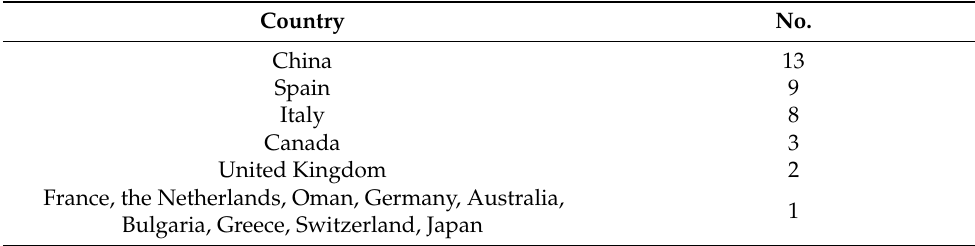
Figure 5. Graphical distribution of first author’s country. Table 5. Number of articles per